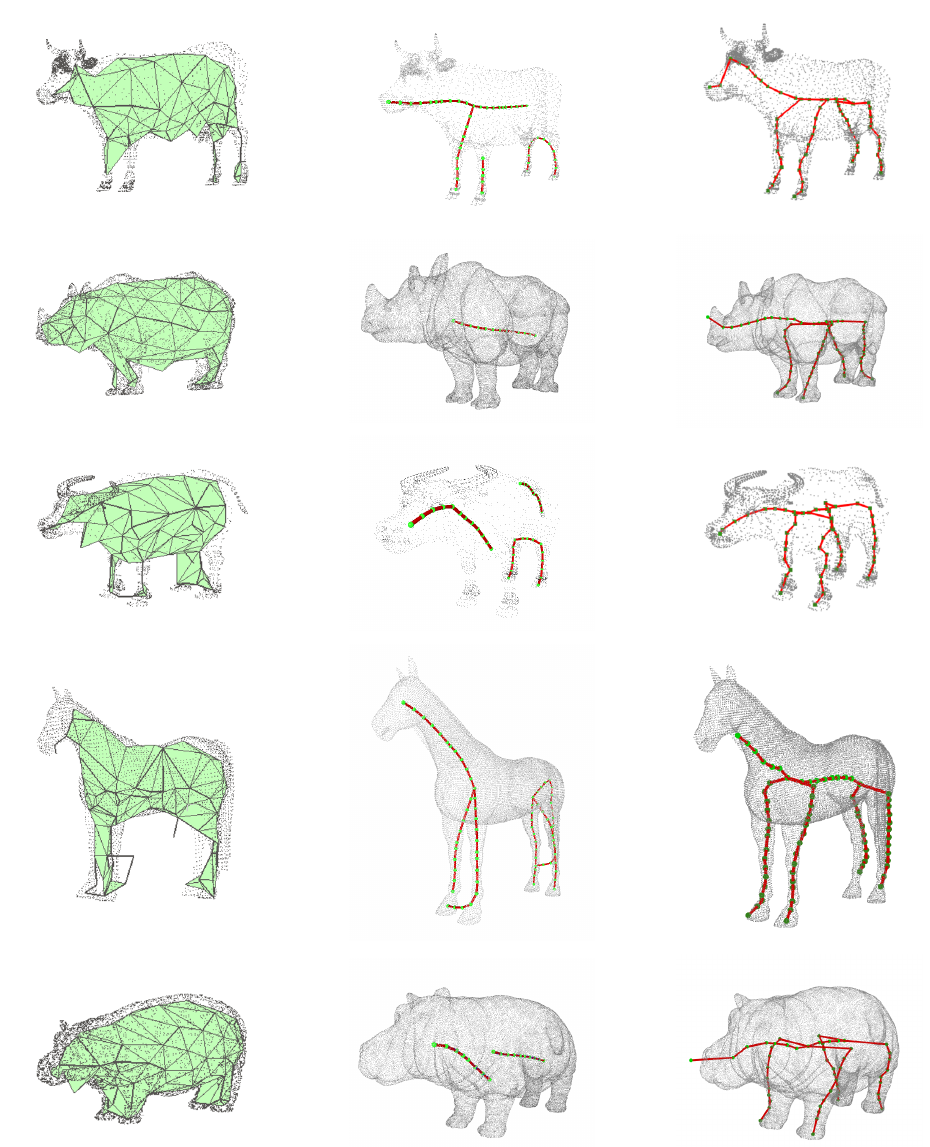
Figure 12. Curve skeletons of different species extracted by the three methods. The results of Point 2 skeleton , L 1 -median, and our method are displayed in the first, second, and third columns,